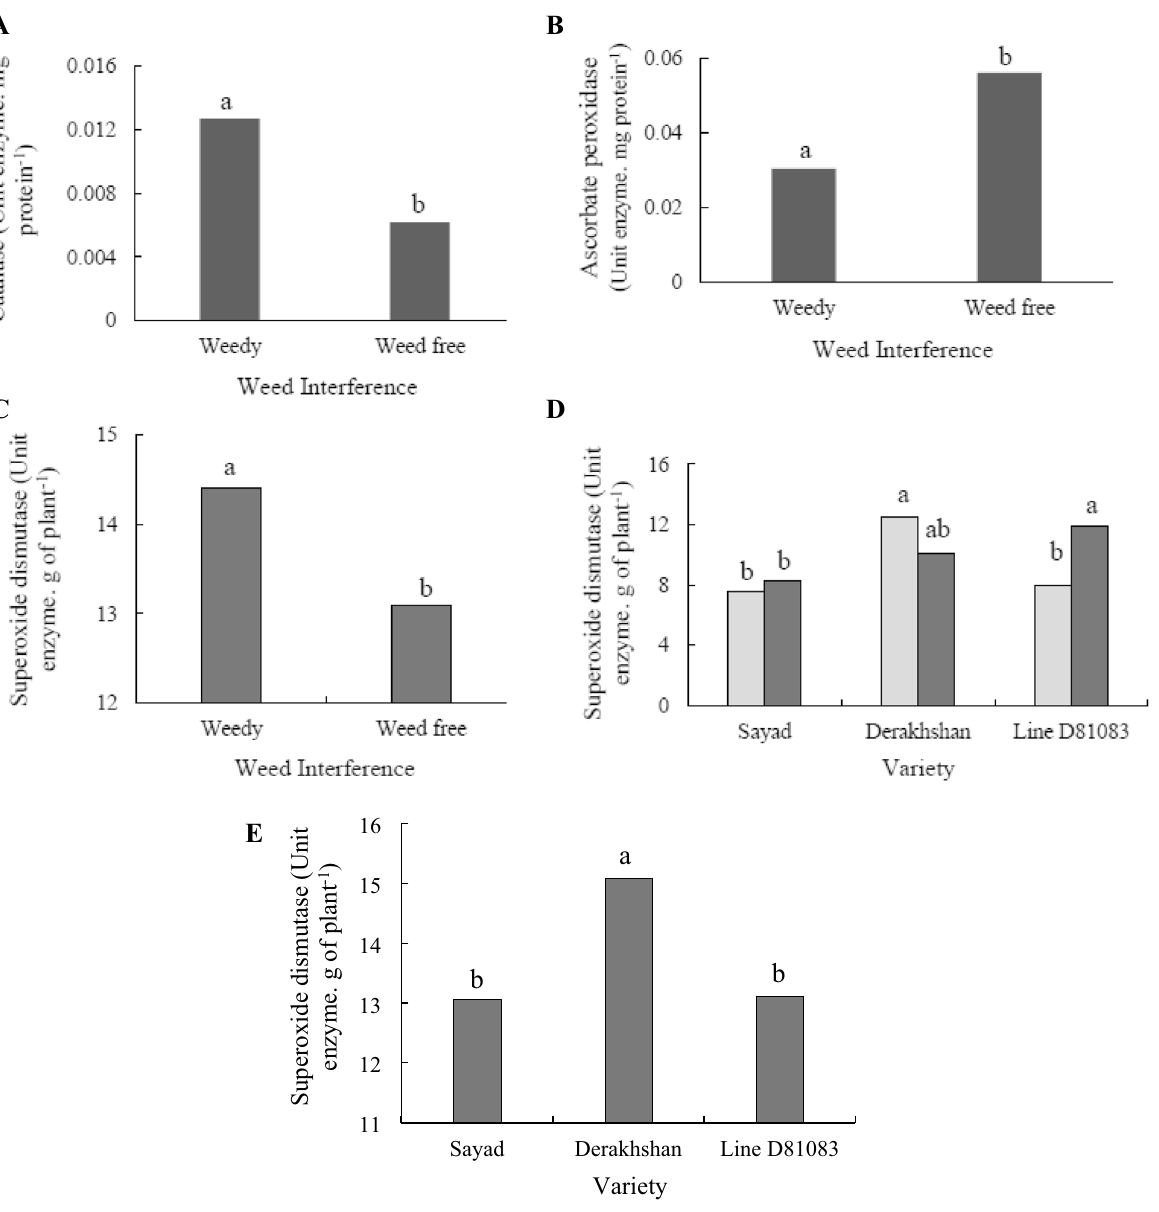
Figure 8. The activity of antioxidant enzymes: ( A ) Catalase content in the V4 stage in two treatments weedy and weed free; ( B ) Ascorbate peroxidas content in V4 stage in two treatments weedy and weed free; ( C ) Super oxide dismutase content in R7 stage in two treatments weedy and weed free; ( D ) Super oxide dismutase content among the cultivars studied in two treatments weedy and weed free in V4 stage (Gray column: weedy; Black column: weed free); ( E ) Super oxide dismutase content among the cultivars studied in Rv